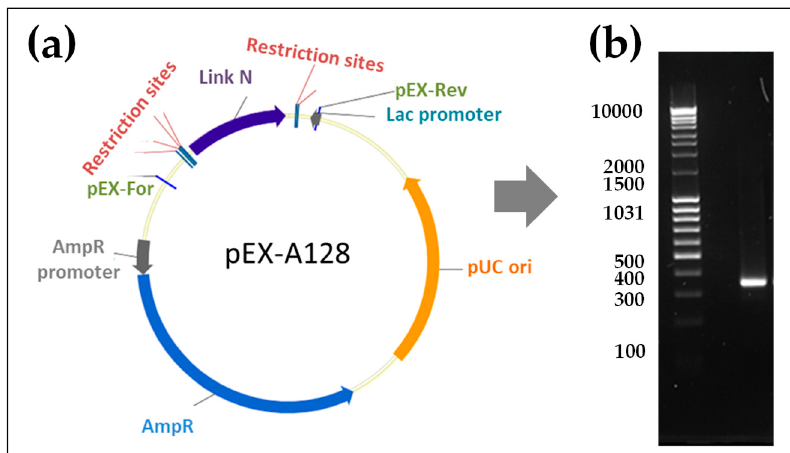
Figure 1. Synthesis of modified Link N mRNA. ( a ) Plasmid insert encoding the Link N peptide was amplified using PCR, and a poly T120 tail was added. The DNA product was then transcribed in vitro into mRNA. ( b ) The generated mRNA product was purified and the specific length and purity were confirmed by agarose gel (1%) electrophoresis. Right Lane: Link N mRNA (351 nucleotides) after the purification, left Lane: 0.5–10 kB RNA ladder.